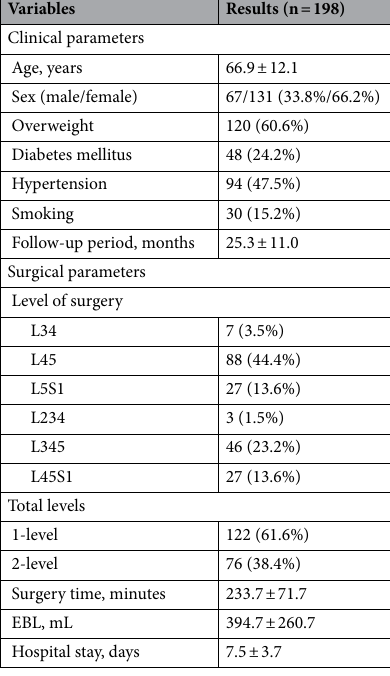
Table 1. Demographics of the enrolled patients. Results are shown as mean ± standard deviation (range) or the number of patients (%). BMI indicates body mass index, BMD bone mineral density, HU Hounsfield unit, VAS visual analog scale, ODI Oswestry disability index, EBL estimated blood